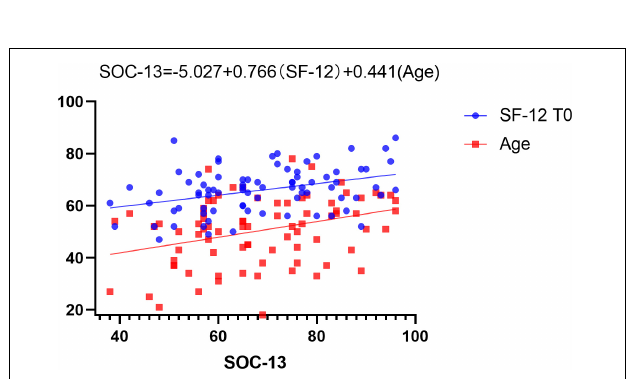
FIGURE 4 | Postoperative satisfaction of patients: A(+): patients with anxiety; D(+): patients with depression; A(–): patients without anxiety; D(–): patients without depression. ** p < 0.01, **** p < 0.001.